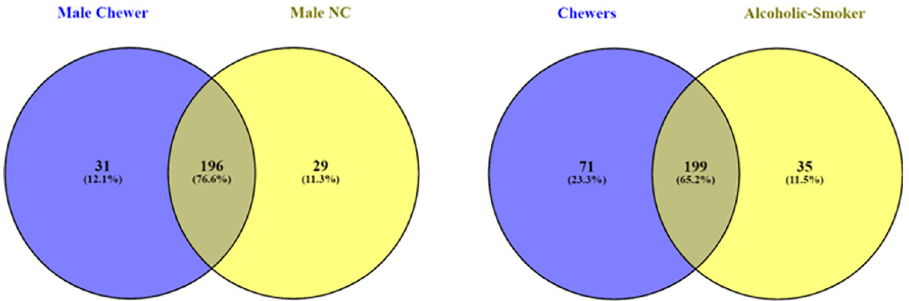
Fig 5. a. Genus-level oral microbiome Unique OTU elements composition of Betel quid Male chewers Vs. Non- Chewers; (Intra-Grouping); b. Betel quid Chewers Vs. Alcoholic-Smoker Chewer individuals.